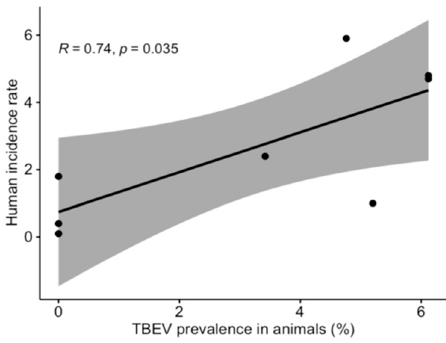
Figure 2. Distribution of TBEV prevalence rates amongst tested farms between the two years of study.